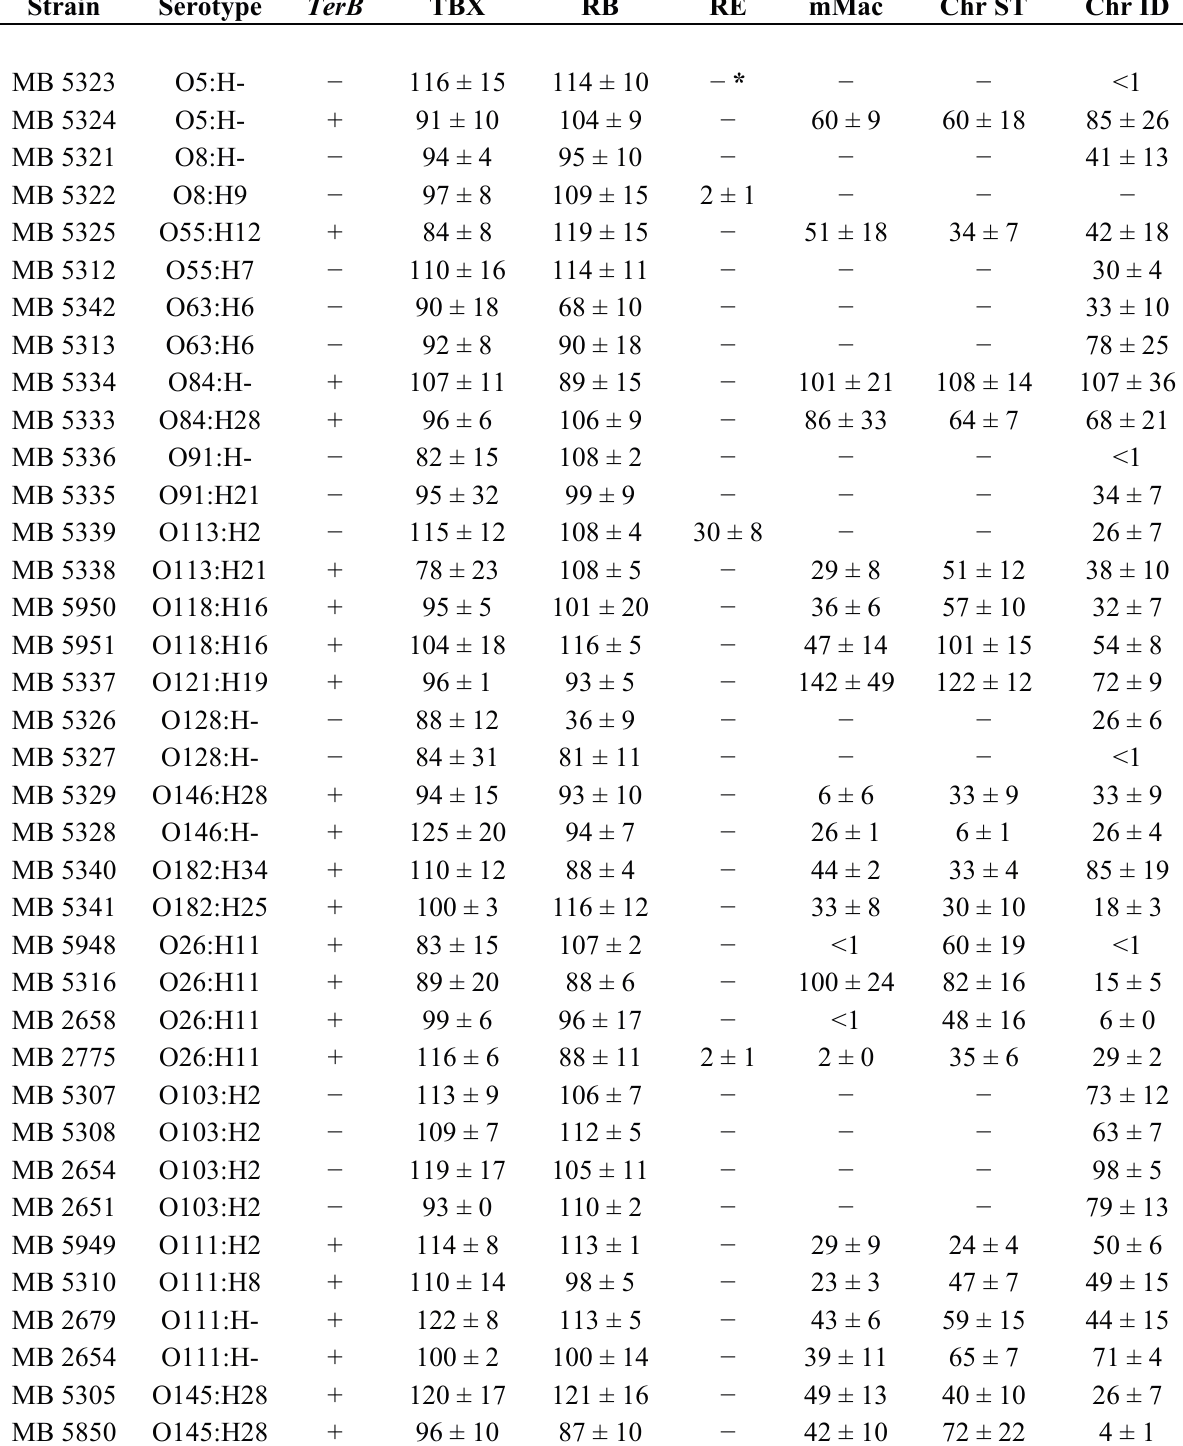
Table 3. The mean recovery percentages of the STEC and non-STEC strains ± standard error on the six chromogenic isolation media compared with the growth on TSA medium (the average concentration of the inocula based on the logarithmic counts on Tryptone Soy Agar (TSA): 4.13 ± 0.12 log 10 cfu/mL). TBX: Tryptone Bile X-glucuronide agar, RB: Rainbow ® Agar O157, RE: Rapid E. coli O157:H7, mMac: Modified MacConkey